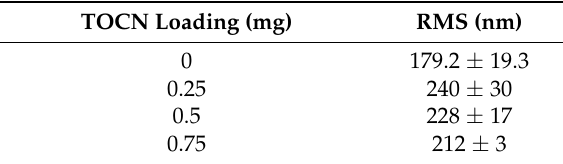
Table A3. Numerical RMS roughness values for membranes fabricated with TOCNs via the dispersion method. dispersion method.